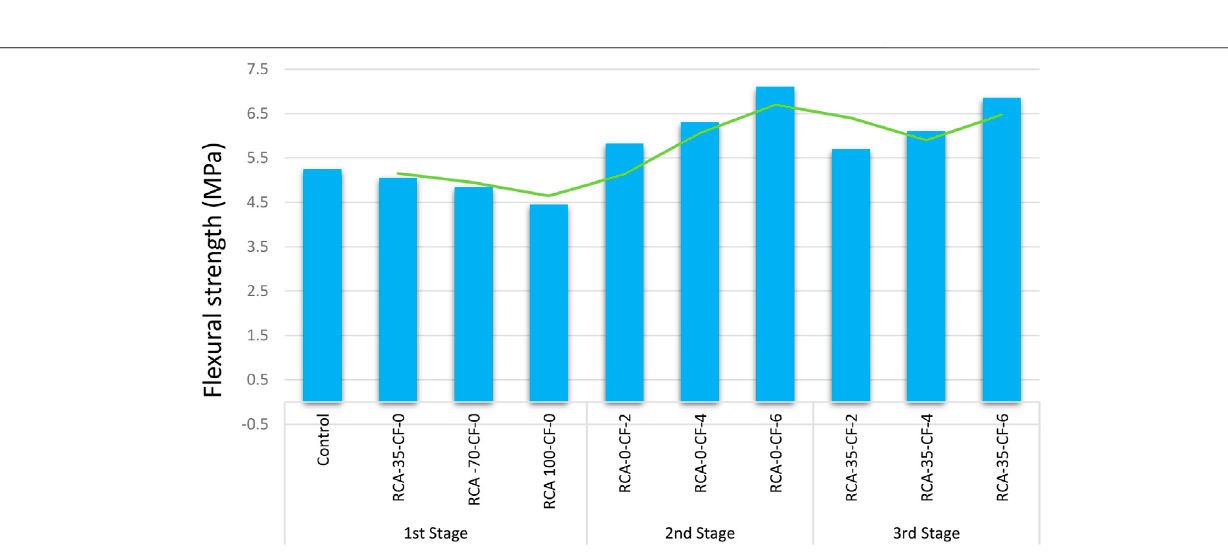
FIGURE 9 | Flexural strength of all concrete samples at 28 days.